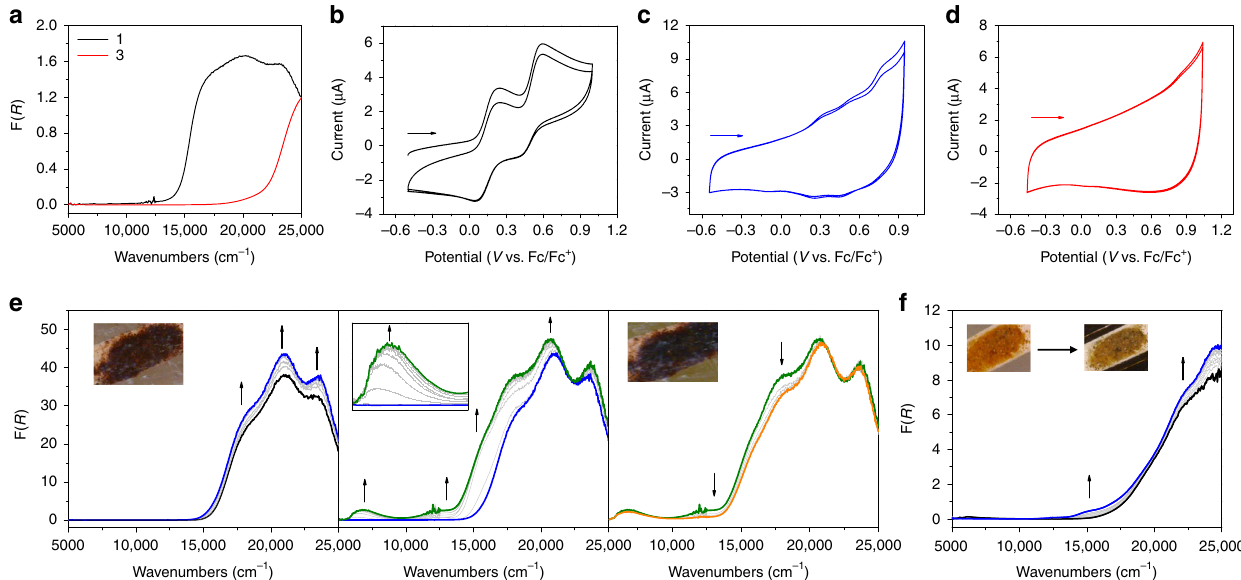
Fig. 3 Photocyclisation dependent electrochemical and spectral data. a Diffuse re fl ectance spectrum of 1 (black) and 3 (red). Cyclic voltammogram of ( b ) 1 , ( c ) 1 after exposure to UV lamp (20W) for 30minutes, and ( d ) 3 in 0.1M [( n -C 4 H 9 ) 4 N]PF 6 /CH 3 CN recorded at 200mVs − 1 . Arrows indicate the direction of the forward scan. ( e ) Vis-NIR SEC of 1 in 0.1M [( n -C 4 H 9 ) 4 N]PF 6 /CH 3 CN between applied potentials of + 0.3 to + 0.6V (left), + 0.6 to + 0.8V (middle) and + 0.8 to + 0.9V (right). Inset fi gures show the colour of the crystals at 0.0V (left) and + 0.8V (right). ( f ) Vis/NIR SEC of 3 between applied potentials of 0.0 to + 0.7V. Inset — starting sample of 3 at 0.0V (left) and the sample at + 0.7V (right). Arrows indicate the direction of the spectral